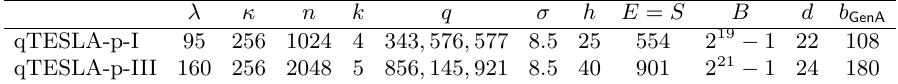
Table 1: Parameters of the two qTESLA parameter sets (Round 2). λ